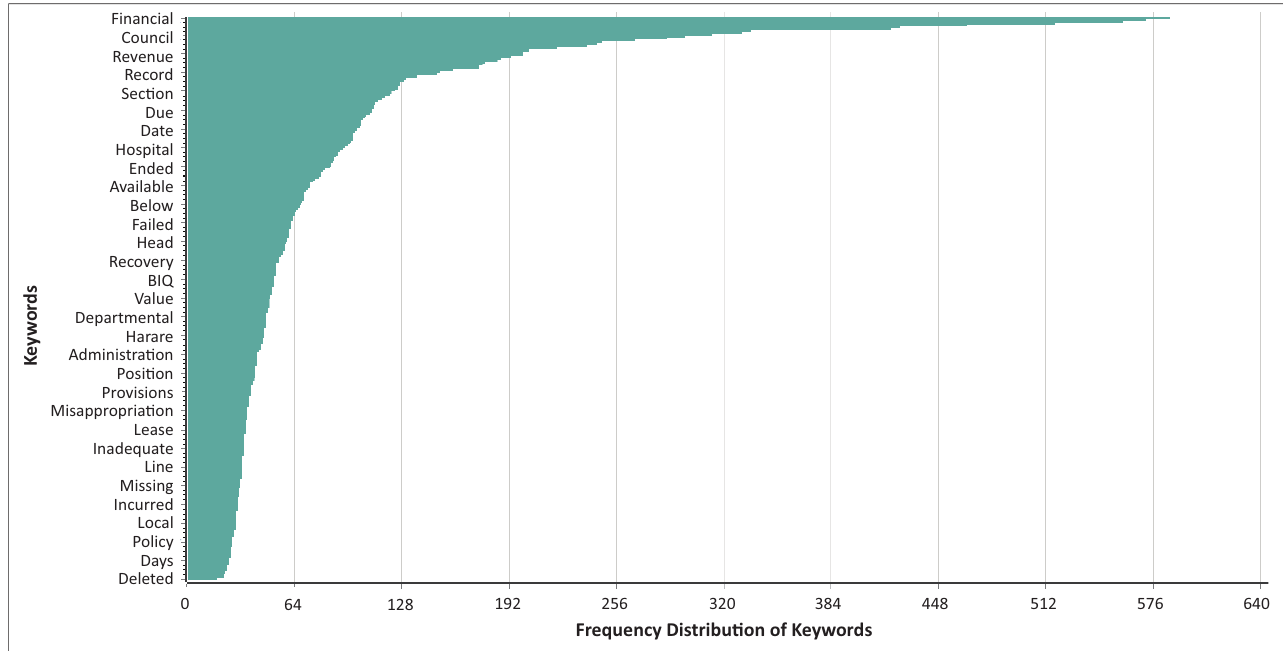
FIGURE 1: Analysis word use metrics in relation to records management issues in the narrative